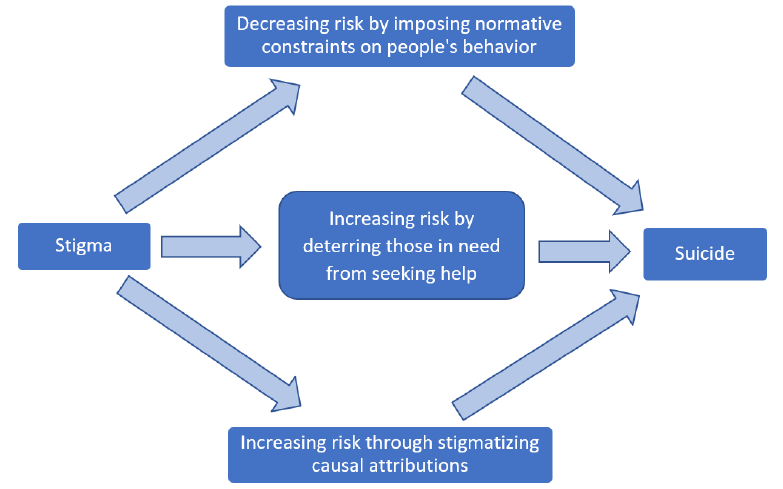
Figure 1. Possible causal mechanisms underlying the effect of stigma on suicide.